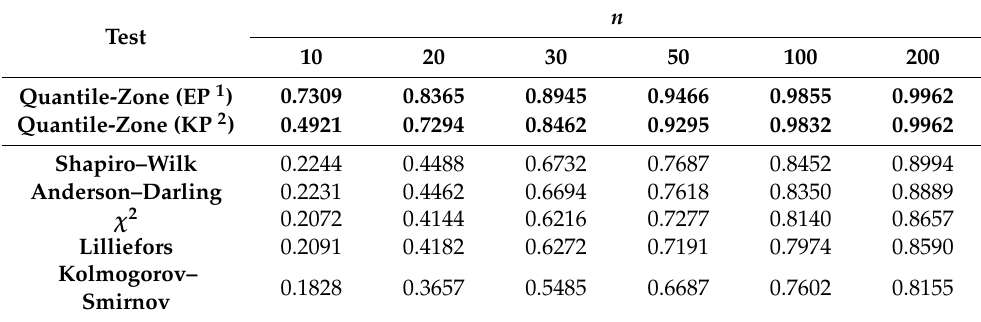
Table 7. Average empirical power values of statistic V n and some other normality test statistics for various sample sizes with the level of significance α = 0.05—Symmetric alternative